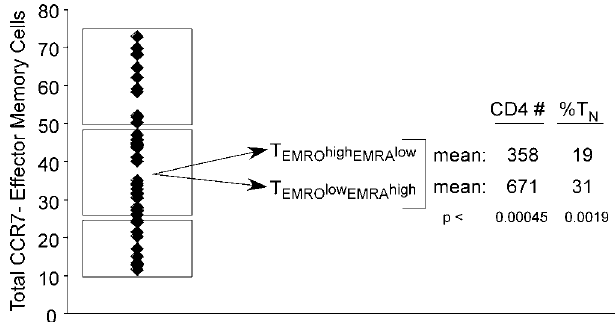
Figure 8. Association between T EM Subsets and CD4 Numbers in HIV- Infected Individuals HIV-infected individuals were separated into three groups based on percent of their CD4 þ T EM cells. The medium T EM population was subdivided into T EMROhigh T EMRAlow and T EMROlow T EMRAhigh , and the number of total CD4 cells and T N cells in each group was calculated. We set the cut-off percentage for defining T EMRO high and low proportions as 28% of CD4 þ T cells and for T EMRA cells, 8% of CD4 þ T cells. Statistical analysis was performed with only the medium group since the bottom group did not contain any T EMRAhigh cells (range: 1.6%– 5.5%) and within the top group all individuals contained high T EMRO cells (range: 31%–59%). Statistical significance between groups was deter- mined by Wilcoxon rank sum test.